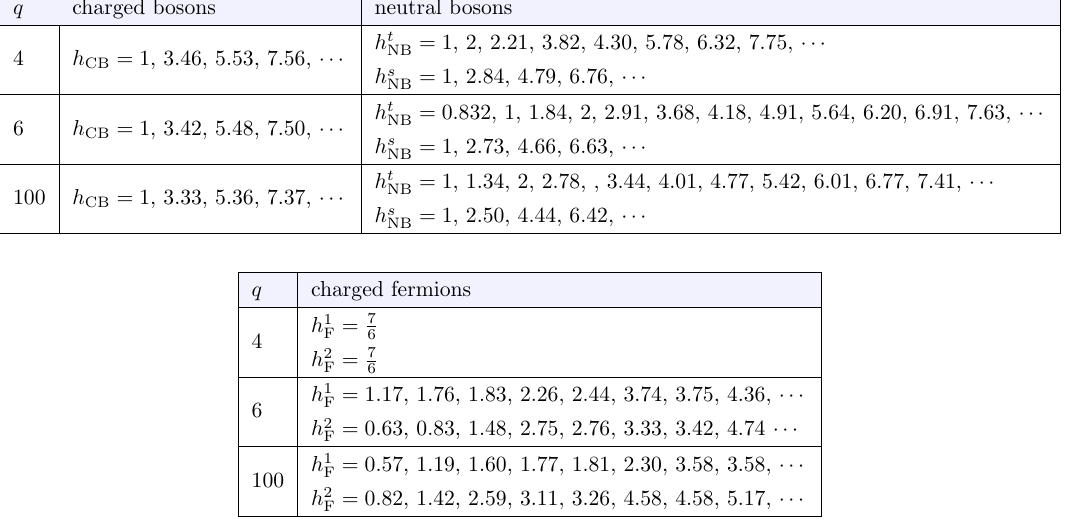
Table 2. Spectrum of (cid:12)rst few low dimension operators for q = 4 ; 6 and 100 (rounded o(cid:11) to two decimals). We have only retained solutions that lie in the range h > 1 text there are no complex solutions for the bosonic states, but the h 2 of complex roots (for q > 4) which however do not lie on the principal continuous line h = 1